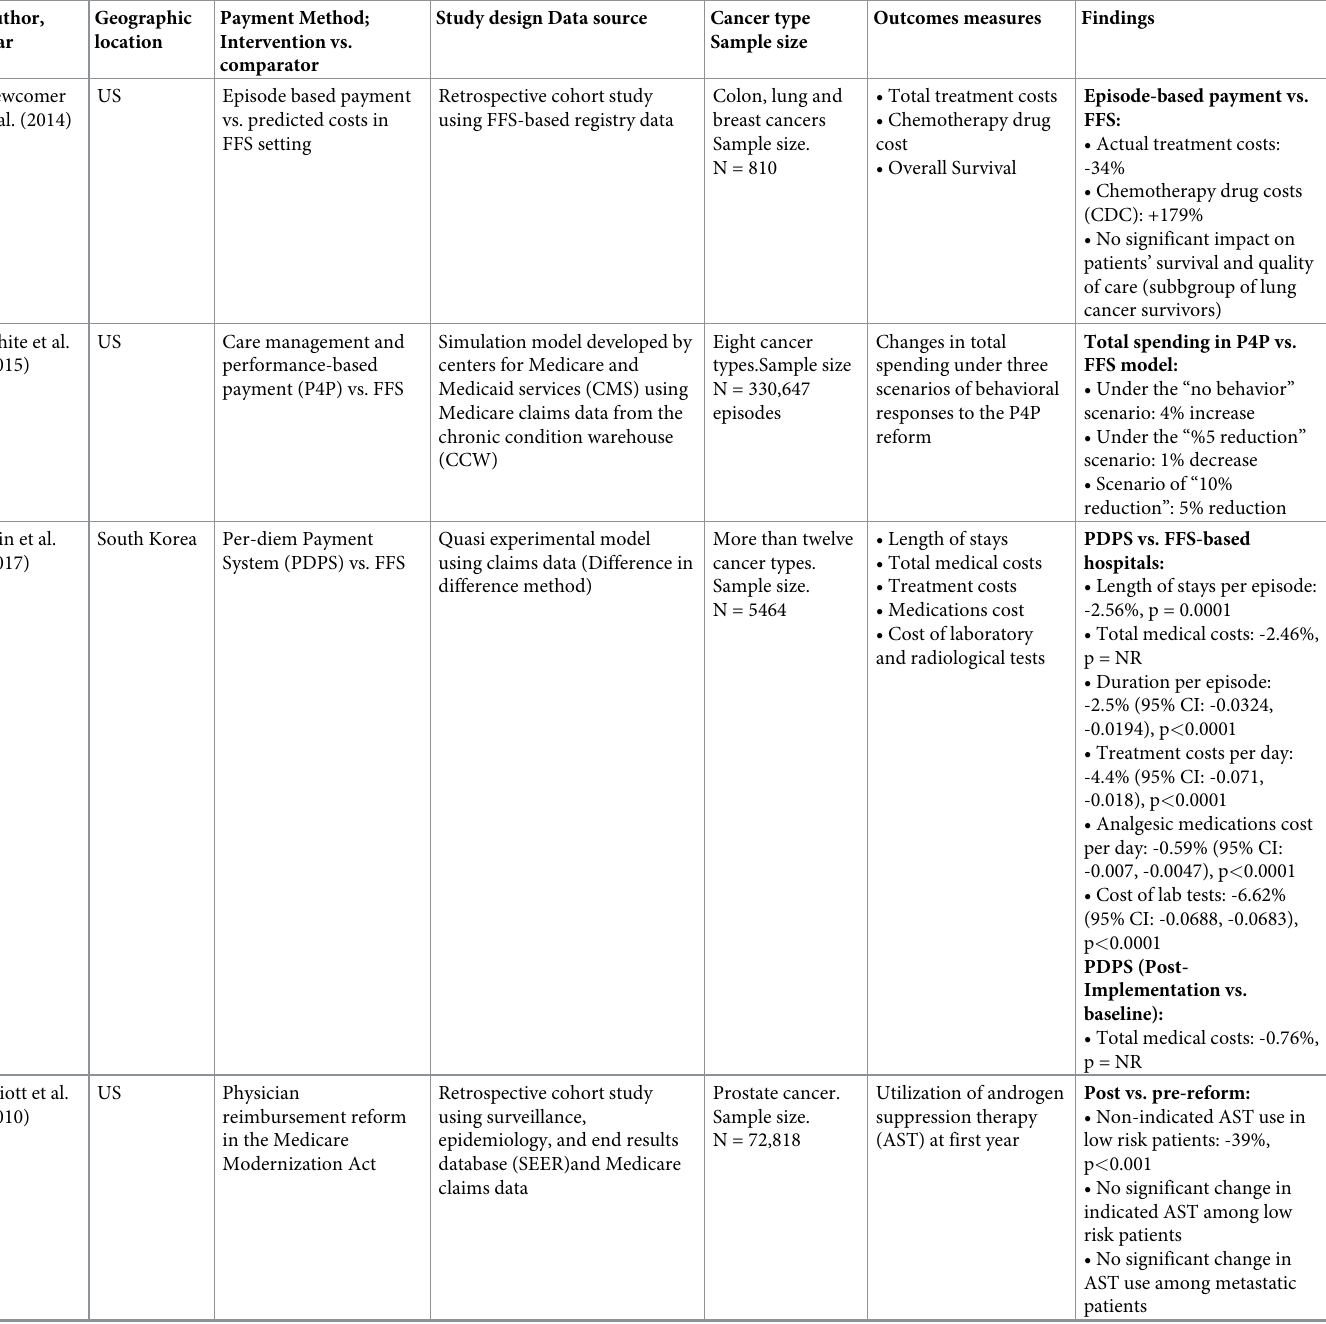
Table 2. Summary of the studies reporting data on the impact of implicit payment reforms in oncology